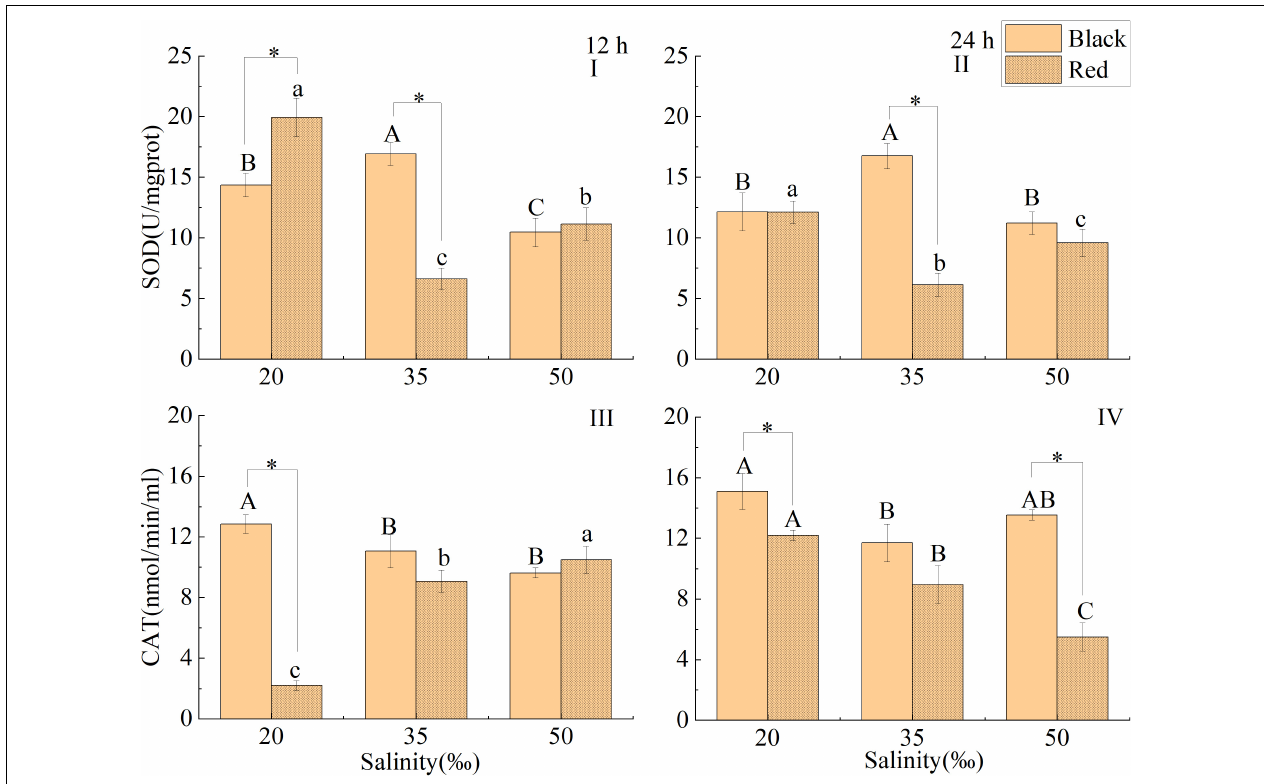
FIGURE 6 | Effects of salinity on SOD and CAT activities in the liver tissue of P. fucata with two shell colors (I: 12h, SOD activity; II: 24h, SOD activity; III: 12h, CAT activity; IV: 24h, CAT